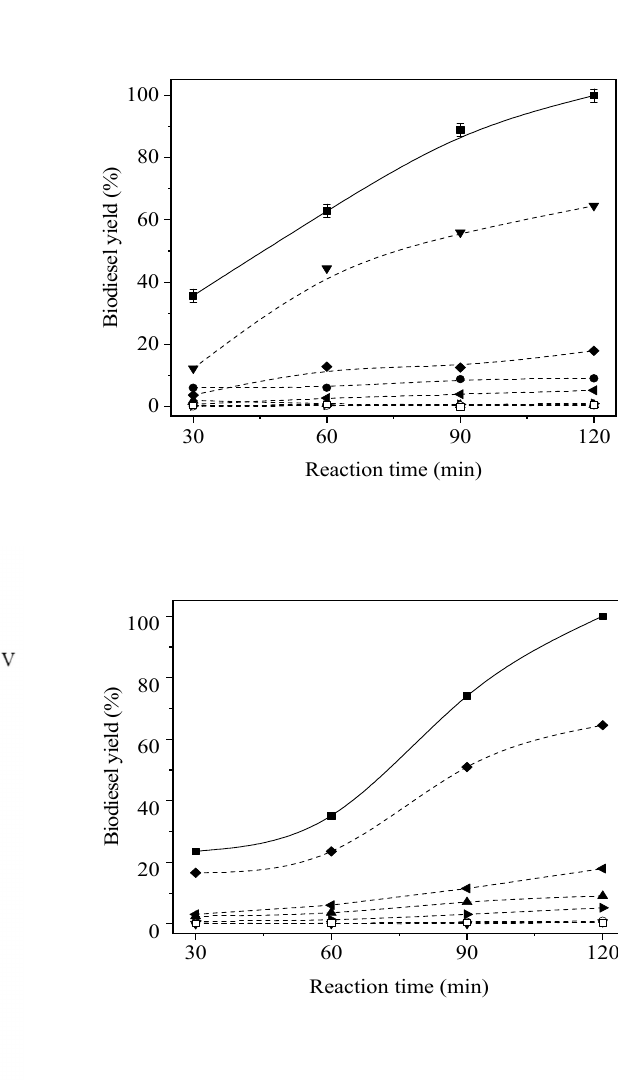
Figure 7. Biodiesel production from macroalgae Fucus vesiculosus oil, ethanol and K 2 CO 3 / γ - Al 2 O 3 /Sepiolite/CoFe 2 O 4 catalyst with reaction parameters: catalyst mass (6%), molar ratio (1:12), reaction temperature (70 ◦ C) and reaction time (2 h). In: ( a ) stirred reactor (200 rpm); ( b ) magnetically stabilized fluidized bed reactor with a recycle flow 7.69 mL/s and 12 mT (1- glass reactor; 2- condenser; 3-coils; 4 system for static magnetic field generation; 5- peristaltic pump for reactional medium recirculation and 6- thermostatic bath for reactor temperarure control). Symbols: ■ total biodiesel yield and fatty acid ethyl ester profiles ( • C16; ▲ C16:1; ▼ C18:2; ♦ C18:1; ◄ C18; ► C18:3; ○ C20:4; (cid:3) C20:5).